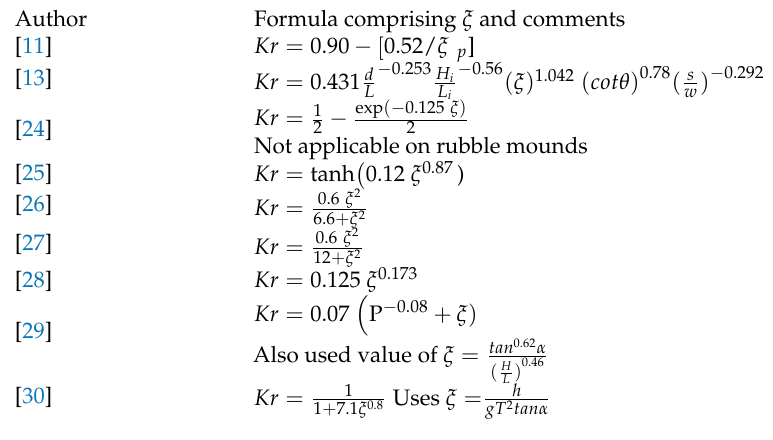
Table A1. Rubble mound seawall formulae adopted for